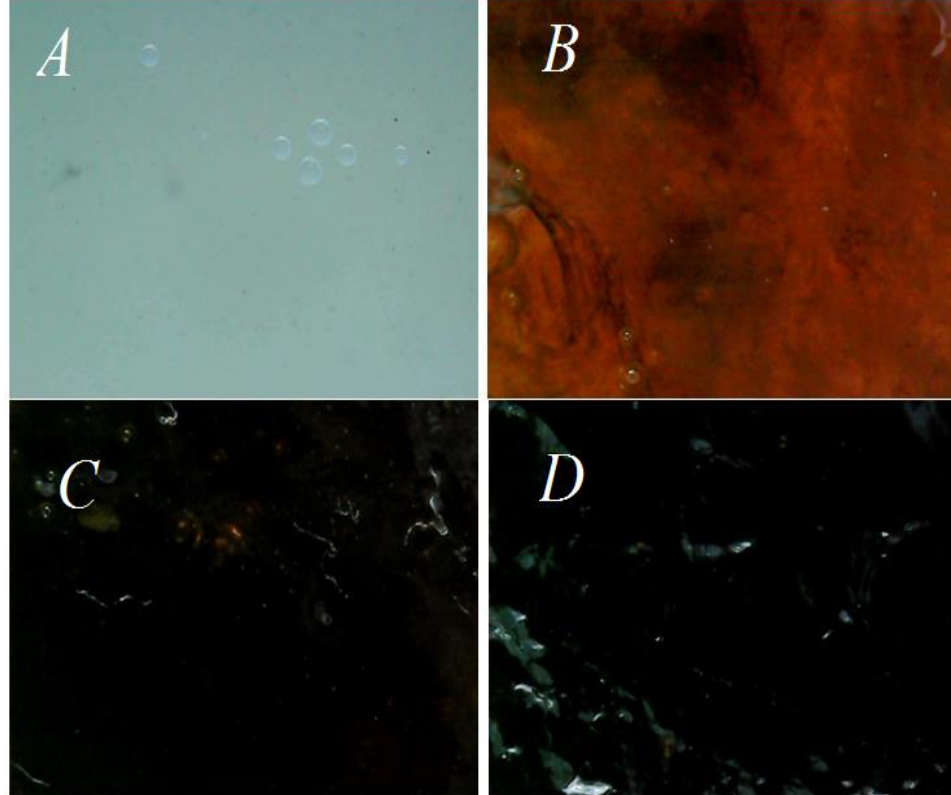
Figure 2. Microscopic studies of HESBHM: ( A ) pure hydroxypropyl methylcellulose and sodium alginate hydrogel; ( B ) hydroxypropyl methylcellulose and sodium alginate hydrogel + 5% wt. of humic acid; ( C ) hydroxypropyl methylcellulose and sodium alginate hydrogel + 10% wt. of humic acid; ( D ) hydroxypropyl methylcellulose and sodium alginate hydrogel + 15% wt. of humic acid.